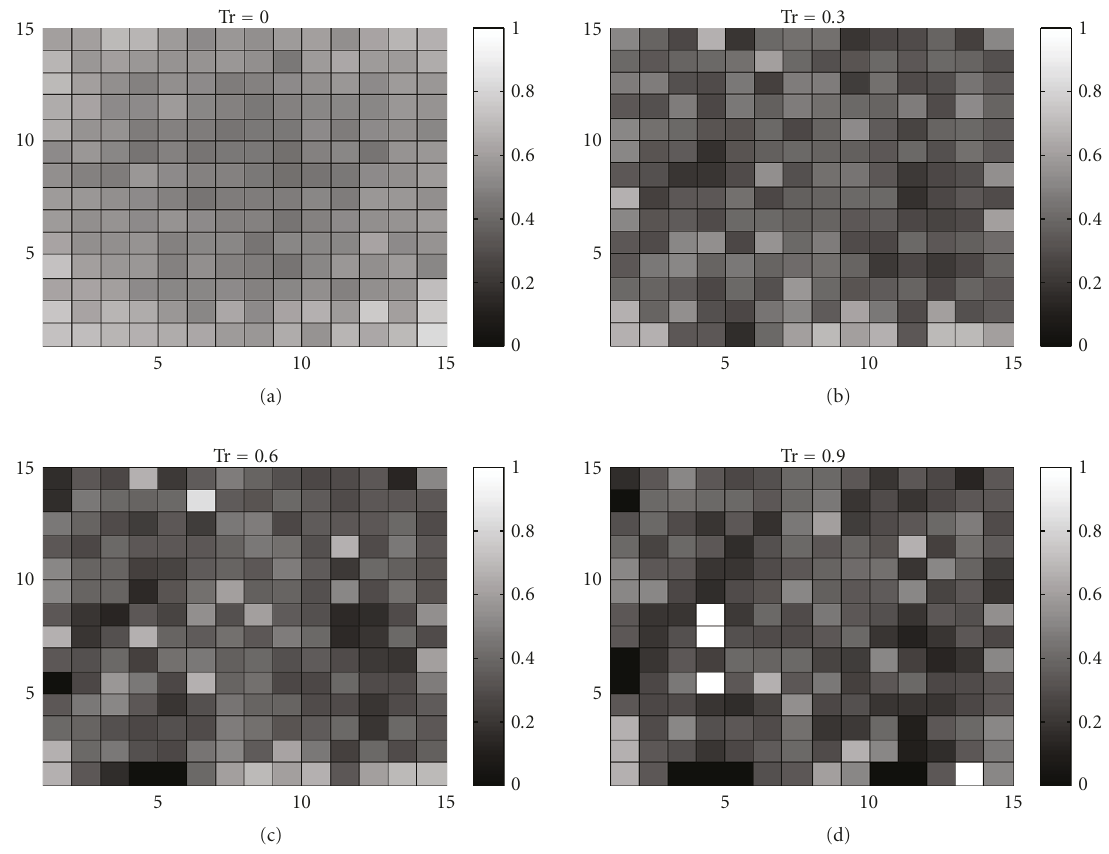
Figure 18: 3D illustration of spatial distribution of clustering coe ffi cient across the graph: simulation data.